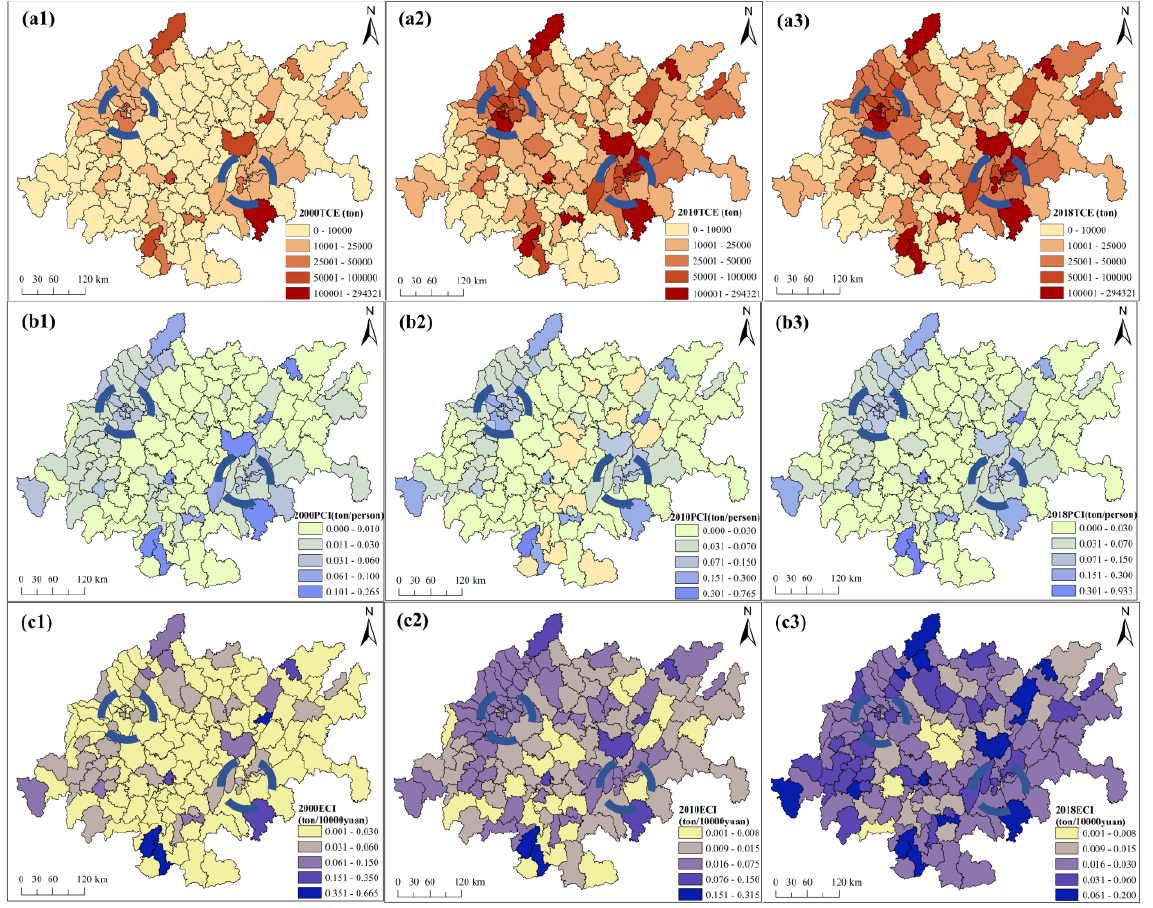
Figure 6 . Spatial distribution of TCE, PCI and ECI in 2000, 2010 and 2018. 337 Figure 6. Spatial distribution of TCE, PCI and ECI in 2000, 2010 and